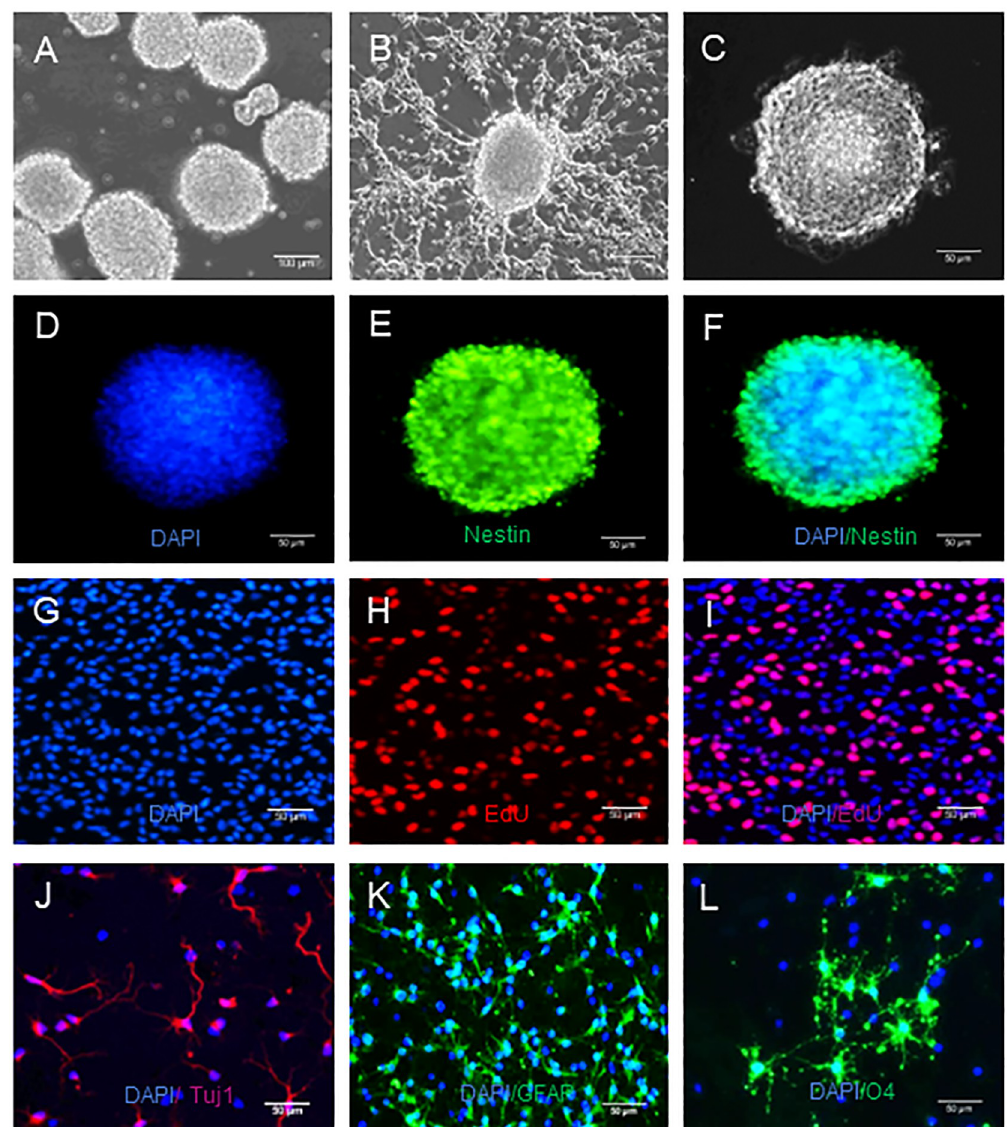
Fig 2. NSCs have the potential of self-renewal and multidirectional differentiation. NSCs were culture for neurosphere formation and differentiation, as described in the method section. The formed neurospheres were imaged and the differentiated neurons, astrocytes and oligodendrocytes were characterized by indirect immunofluorescence. Data are representative images of different types of cells from three separate experiments. A. A microscopic image (magnification 10 x) of typical neurospheres. Scale bar = 100 um. B. The morphology of differentiated cells from NSCs. C. Light microscopy viewed NSCs. Magnification 20 x, Scale bar = 50 um. D-F. Indirect immunofluorescent analysis of neurosphere using anti-Nestin and Alexa Fluor 488-conjugated donkey anti-mouse IgG as well as DAPI. Magnification 20 x, Scale bar = 50 um. G-I. EdU+ cells indicate cell proliferation. Magnification 20 x, Scale bar = 50 um. J-L. Indirect immunofuorescent analysis of differentiated Tuj1+ neurons, GFAP+ astrocytes and O4+ oligodendrocytes using anti- Tuj1, anti-GFAP, anti-O4 and Alexa Fluor 574-labeled donkey anti-rabbit and Alexa Fluor 488-conjugated donkey anti-mouse as well as DAPI, respectively. Magnification 20 x, Scale bar = 50